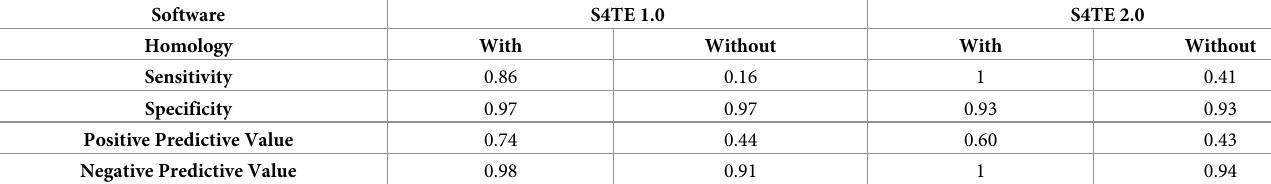
Table 2. Performances comparison between S4TE 1.0 and S4TE 2.0 algorithms with or without the homology search module.